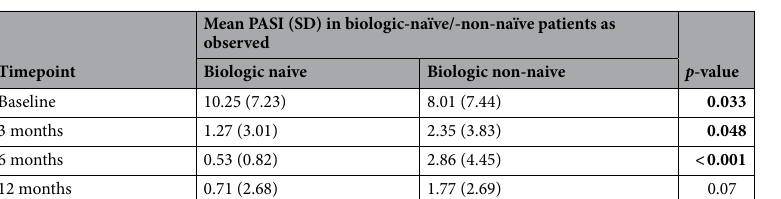
Table 2. Treatment effectiveness regarding biologic naivety. A two-sample t -test revealed significantly higher PASI values in biologic naïve patients at treatment start, as well as significantly higher PASI values in biologic- non-naïve patients at 3 and 6 months after treatment initiation. Significant p -values are in bold. PASI, Psoriasis Area and Severity Index; SD, standard